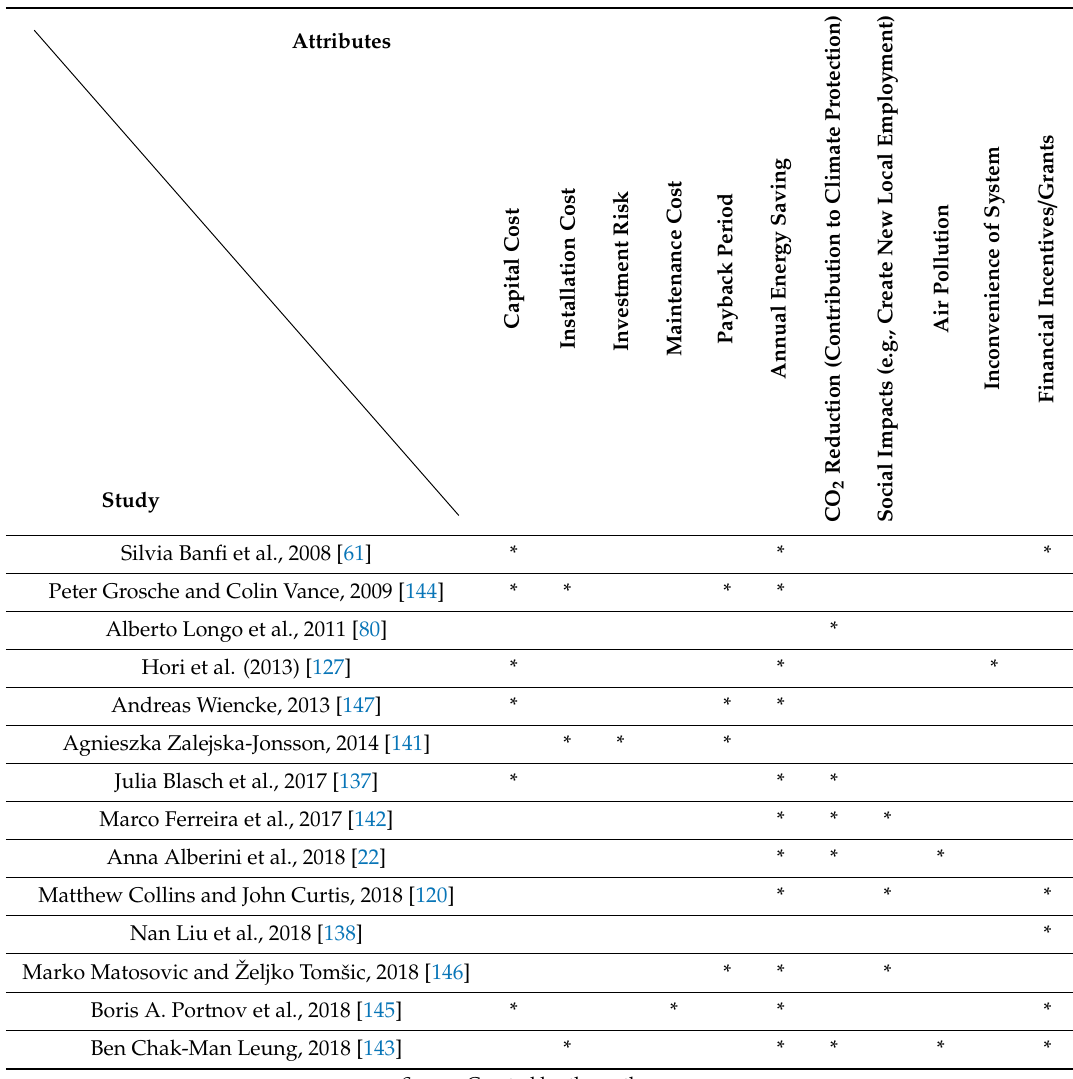
Table 6. Summary of attributes used in empirical studies on WTP for energy